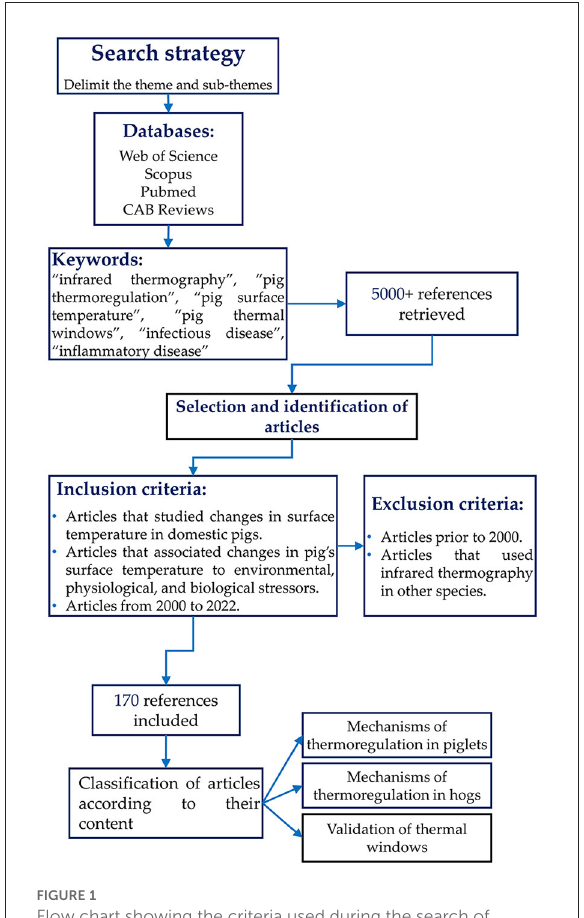
FIGURE1 Flow chart showing the criteria used during the search of scientific articles for the overview.